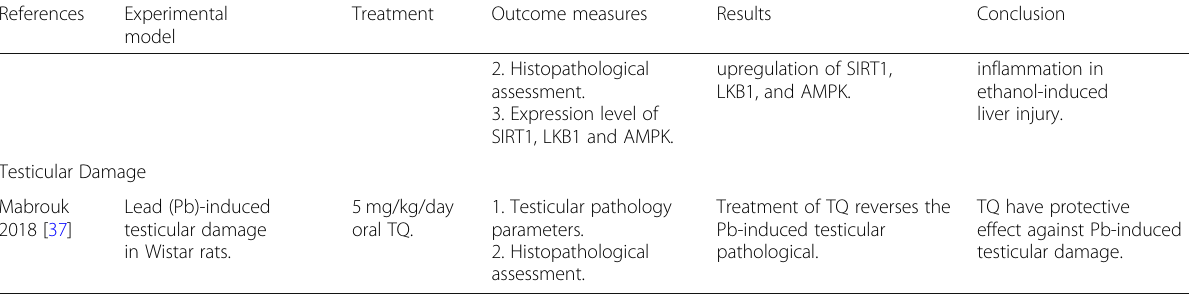
Table 3 Effect of Nigella sativa and thymoquinone on inflammation